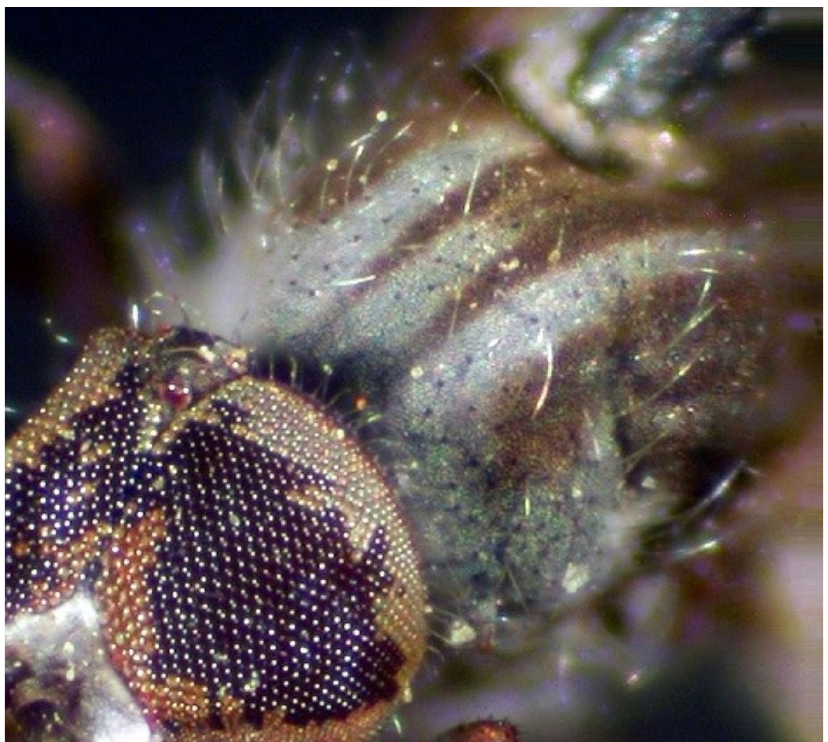
Fig. 11. Protypusia hyalipennis (Séguy, 1941) gen. et comb. nov.,